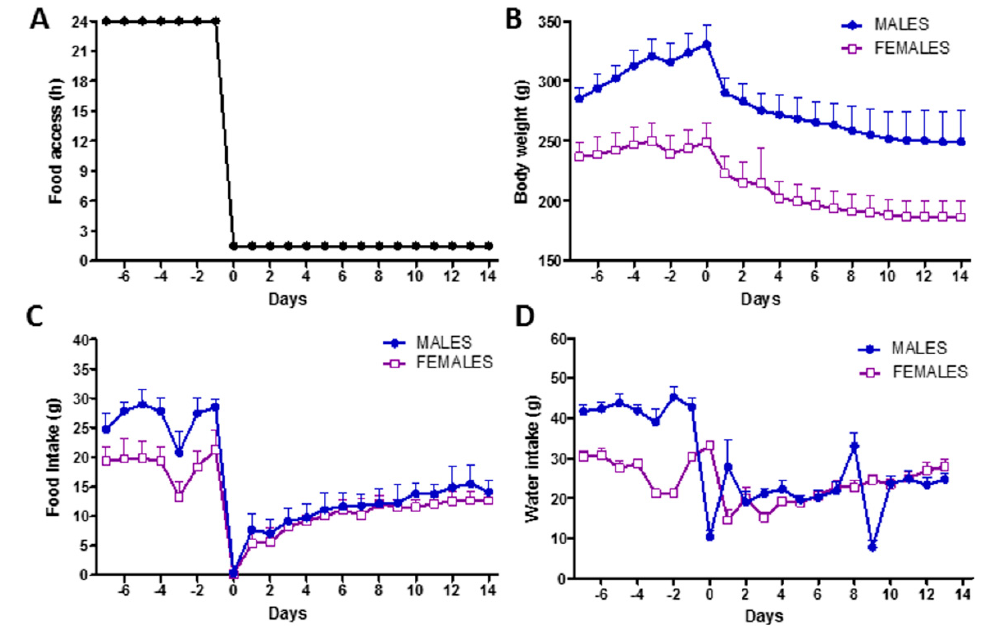
Figure 1. Rat model of chronic food restriction. ( A ) Experimental design showing the food access per day. ( B ) Body weight dynamics. ( C ) Daily food intake dynamics. ( D ) Daily water intake dynamics.